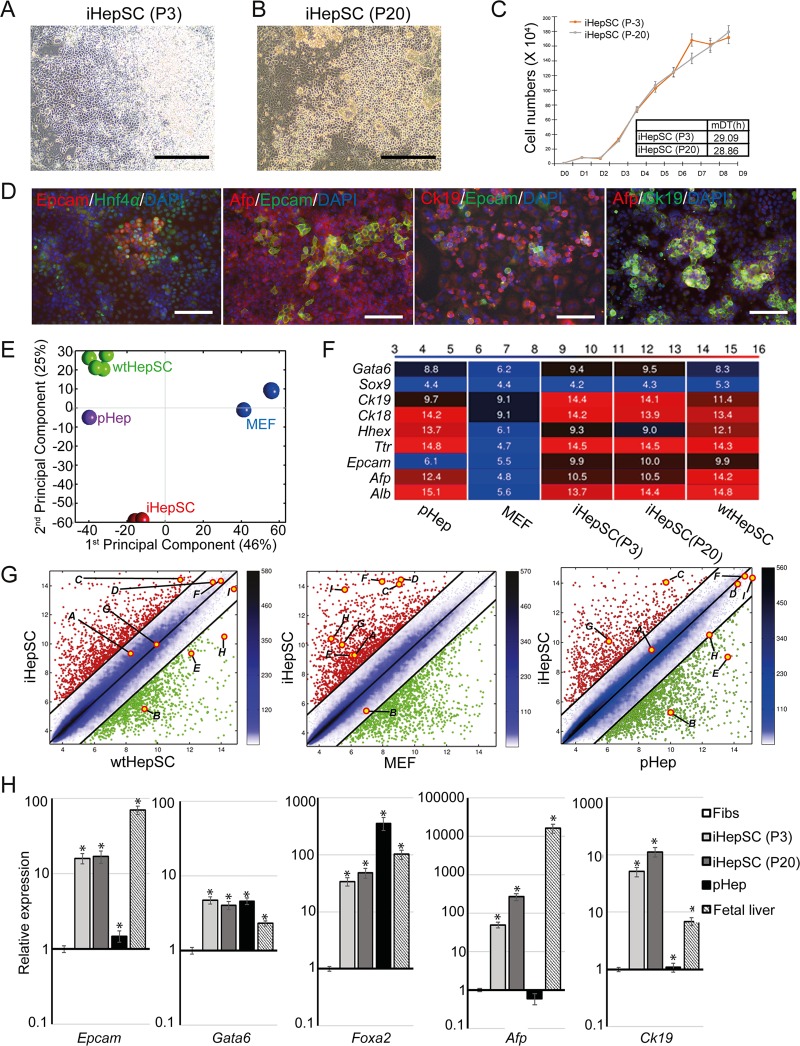
Characterization of iHepSCs.(A-B) Images of iHepSCs at early passage (passage 3, P3, A) and late passage (passage 20, P20, B). Scale bar: 250 μm. (C) Growth curves for iHepSCs at early and late passage. The points refer to the cell numbers of iHepSCs on each day. The table represents the mean doubling time (mDT) of early (P3) and late (P20) iHepSCs for ten days. The experiment was carried out triplicate (n = 3). (D) Immunofluorescence images of iHepSCs stained with HepSC markers (Epithelial cell adhesion molecule: Epcam; hepatocyte nuclear factor 4 α: Hnf4; α-fetoprotein: Afp; Cytokeratin19: Ck19). The cells were counterstained with DAPI. Scale bar: 150 μm. (E) PCA analysis of mouse embryonic fibroblasts (MEF), wild-type HepSC (wtHepSC), primary hepatocytes (pHep) and iHepSCs (early and late passage). (F) Heatmap analysis of the selected genes involved in the hepatic lineage. The color bar in the top codifies the gene expression level in log2 scale. (G) Pairwise scatter plots of samples; iHepSC vs. wtHepSC, iHepSC vs. MEF, and iHepSC vs. pHep. Hepatic markers were labelled as follow; (a) Gata6, (b) Sox9, (c) Ck19, (d) Ck18, (e) Hhex, (f) Ttr, (g) Epcam, (h) Afp, (i) Alb. (H) Expressional levels of hepatic genes of the parental cell (Fibs), fetal liver, iHepSC (early and late passage) and pHep. The transcriptional levels were normalized to the housekeeping gene (Gapdh). Error bars indicate standard errors from triplicate samples (n = 3). *, P<0.05.